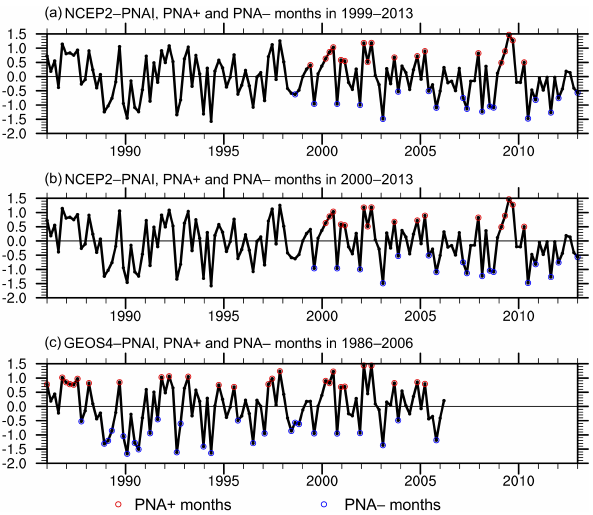
Figure 2. (a) PNAI for the years 1986–2013 calculated using the NCEP-2 data (NCEP2-PNAI), with the PNA + and PNA − months during 1999–2013 indicated. (b) PNAI for the years 1986–2013 calculated using the NCEP-2 data, with the PNA + and PNA − months during 2000–2013 indicated. (c) PNAI for the years 1986– 2006 calculated using the GEOS-4 data (GEOS4-PNAI), with the PNA + and PNA − months over 1986–2006 indicated. Red circles are PNA + months and blue circles PNA − months. The PNA + (PNA − ) months are defined as the 25% of winter months exam- ined, which have the highest positive (negative) PNA index values.